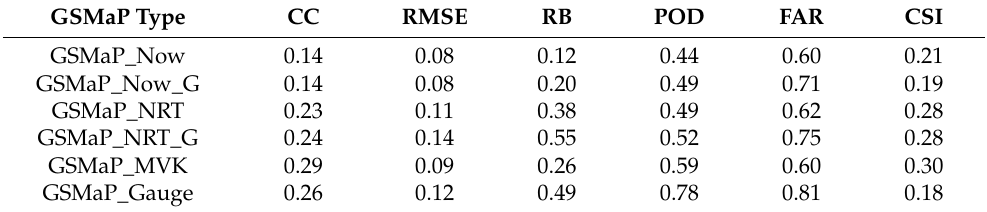
Figure 2. Boxplot of CC (a), RMSE (b), RB (c), POD (d), FAR (e), and CSI (f) for hourly GSMaP data for all RG’s stations. Table 5. The mean of validation data matrix for hourly data for all